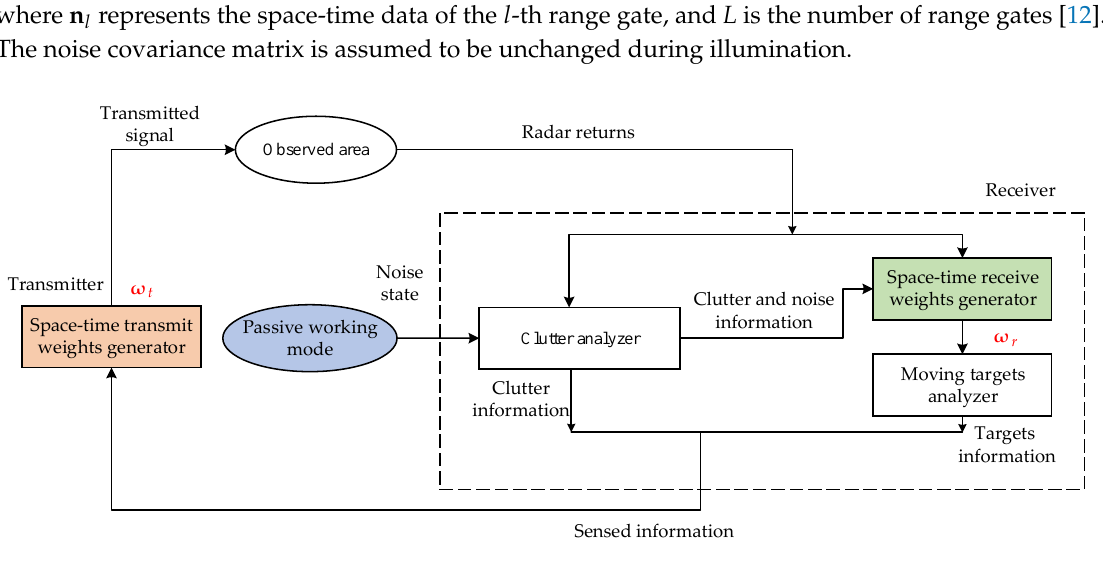
Figure 2. Joint design of space-time transmit and receive weights.